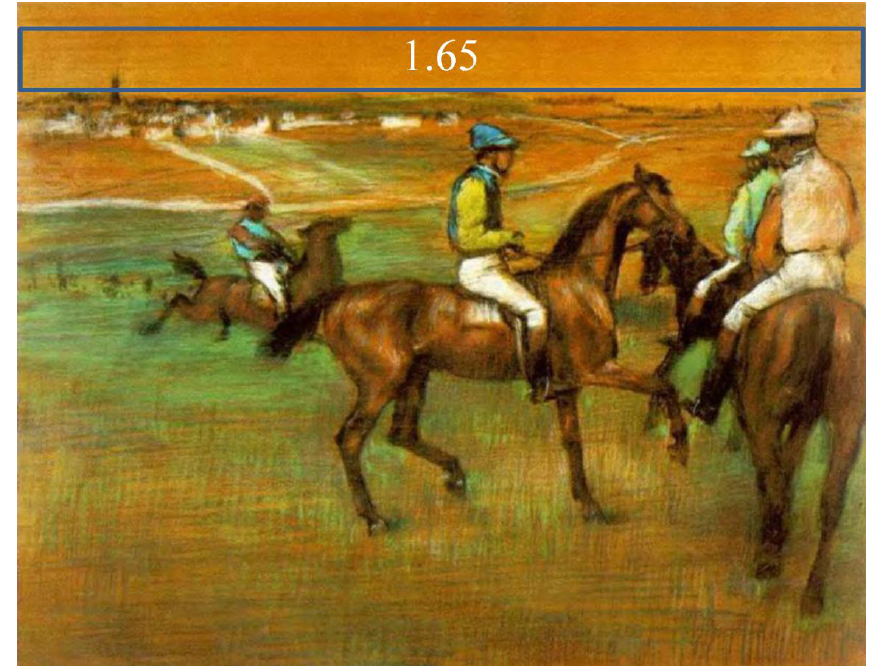
Fig. C6. Edgar Degas, Race Horses, 1885. Corresponding R/G ratios were averaged inside the box.